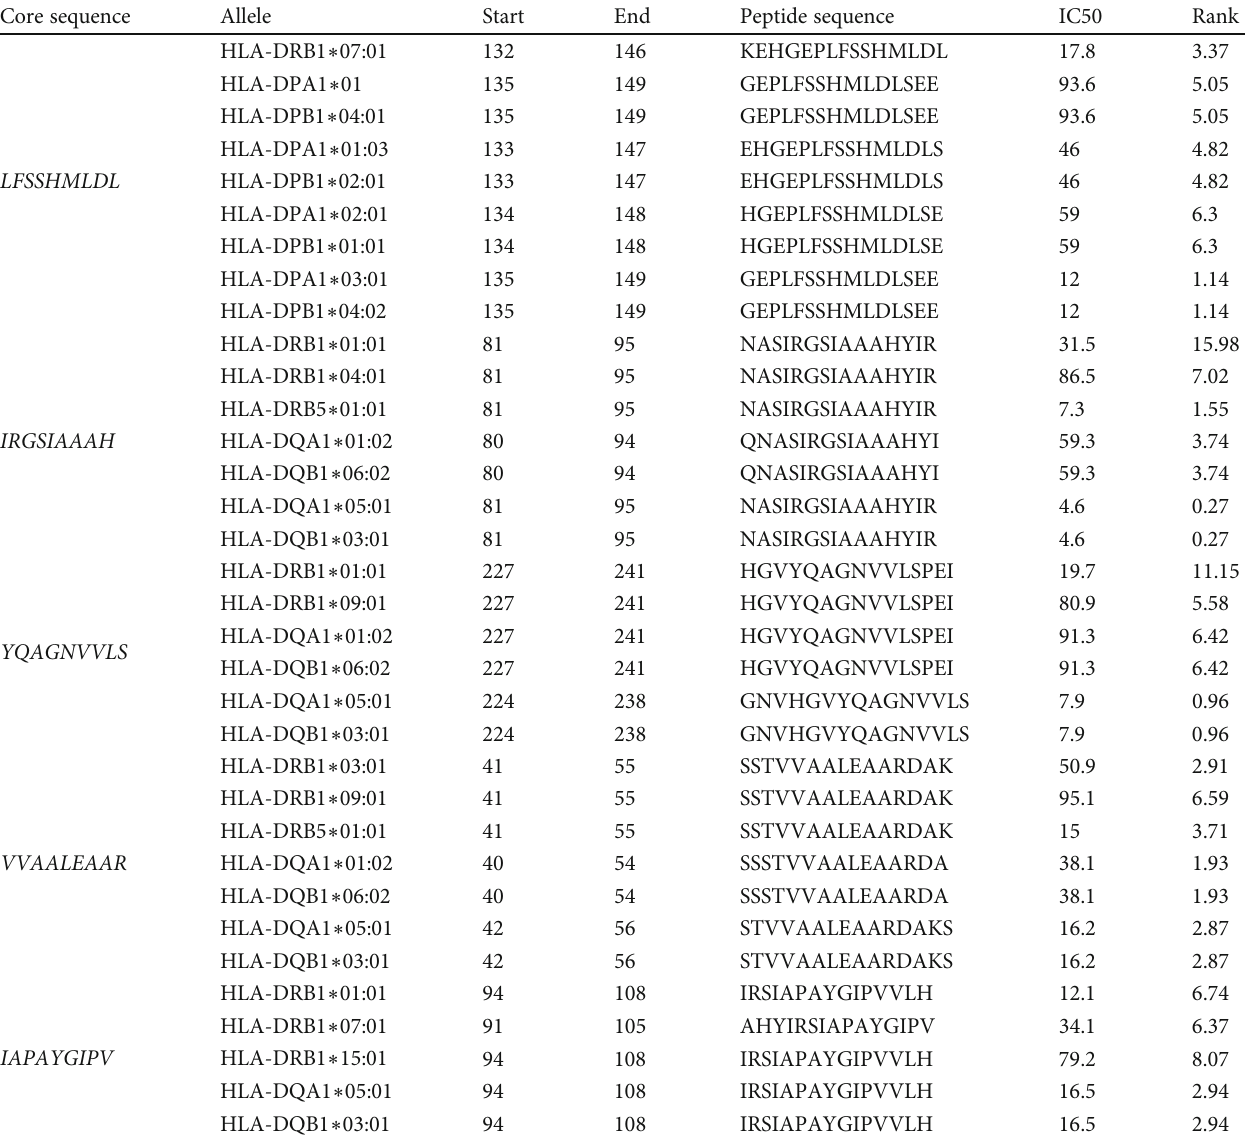
Table 5: Promising T-cell epitope (class MHC II alleles) with their position and peptide sequence and IC50 value and rank. Core sequence